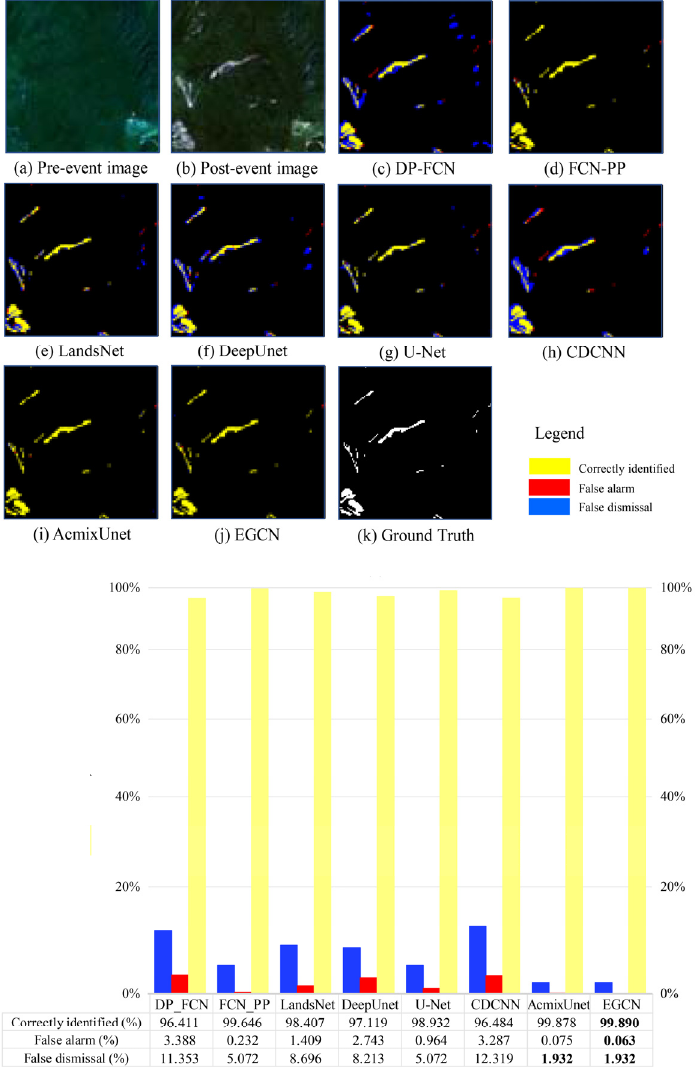
Figure 8. Comparison of the identification results of 8 methods in Region B. Bold values mean the highest number of the corresponding evaluation criterion.